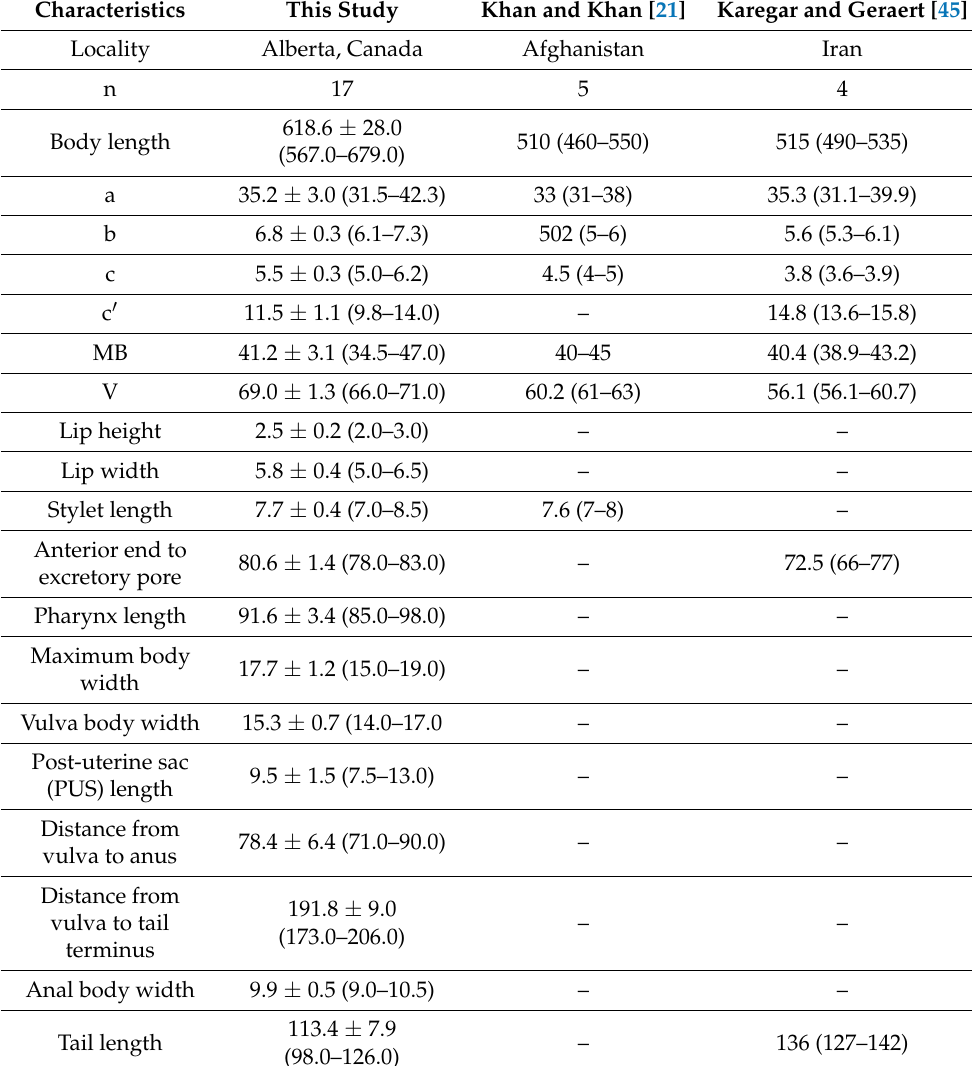
Table 3. Morphometrics of female Filenchus sheri (Khan and Khan) Siddiqi [21,22] examined in this study and from the original and subsequently published descriptions. All measurements are in µ m and in the form: mean ± standard deviation and/or